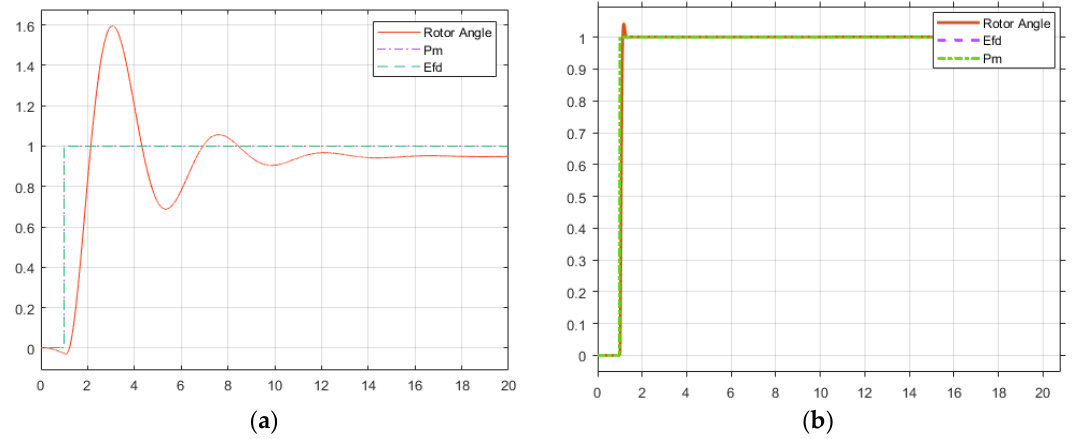
Figure 6. Rotor angle’s response when E (cid:2890)(cid:2888) = 1 , P (cid:2923) = 1 . ( a ) The Lyapunov-based trajectory tracking controller is applied to the system; ( b ) The MRAC is applied to the system. controller is applied to the system; ( b ) The MRAC is applied to the